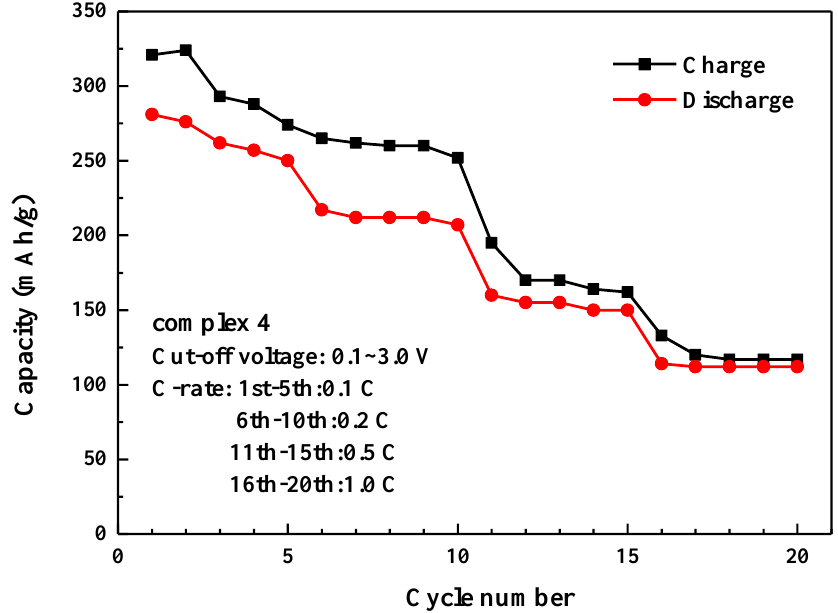
Figure 9. Rate capability tests of complexes 3 and 4 with potential window 0.1–3.0 V.